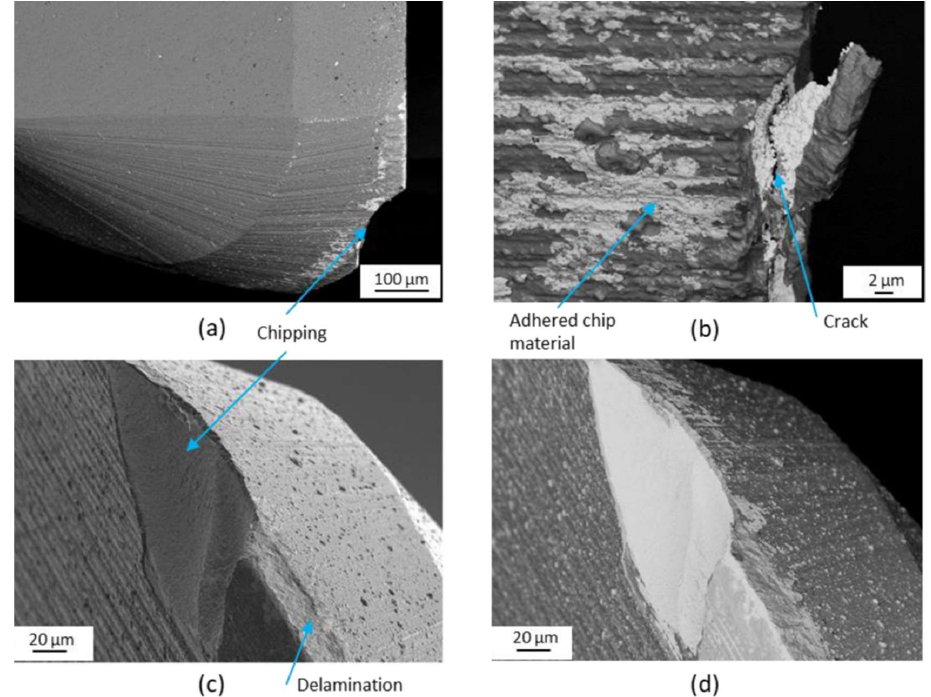
Figure 9. Tool wear mechanisms when machining as-built SLM Ti-6Al-4V alloy: ( a – c ) the built-up layer of titanium material, coating delamination, fracture, and chipping of the cutting edge; ( d ) SEM micrograph of the cutting tool after a cutting length of 500 m [121] (Reprinted with permission from [121]. Copyright 2020, Elsevier).